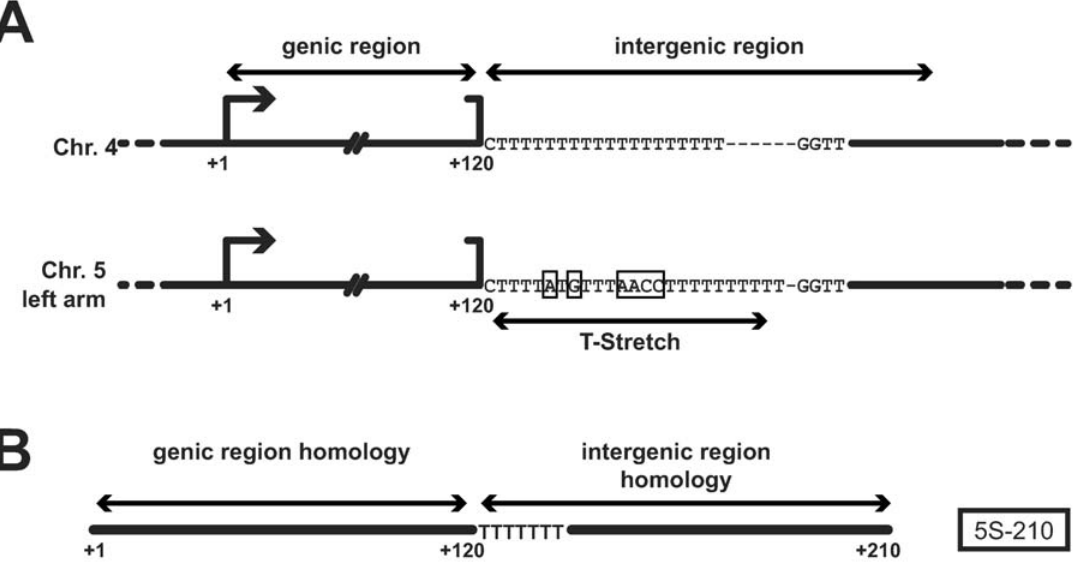
Figure 1. Schematic representation of a 5S rDNA unit and 5S-210 transcript. (A) A 5S rDNA unit contains the 120 bp-genic region followed by the intergenic region containing the 5S array-specific T-stretch. Boxes represent differences between the T-stretch from chromosome 4 and chromosome 5 left arm. (B) The 5S-210 transcript is homologous to the 120 nt-genic region and 90 nt from the adjacent intergenic region.